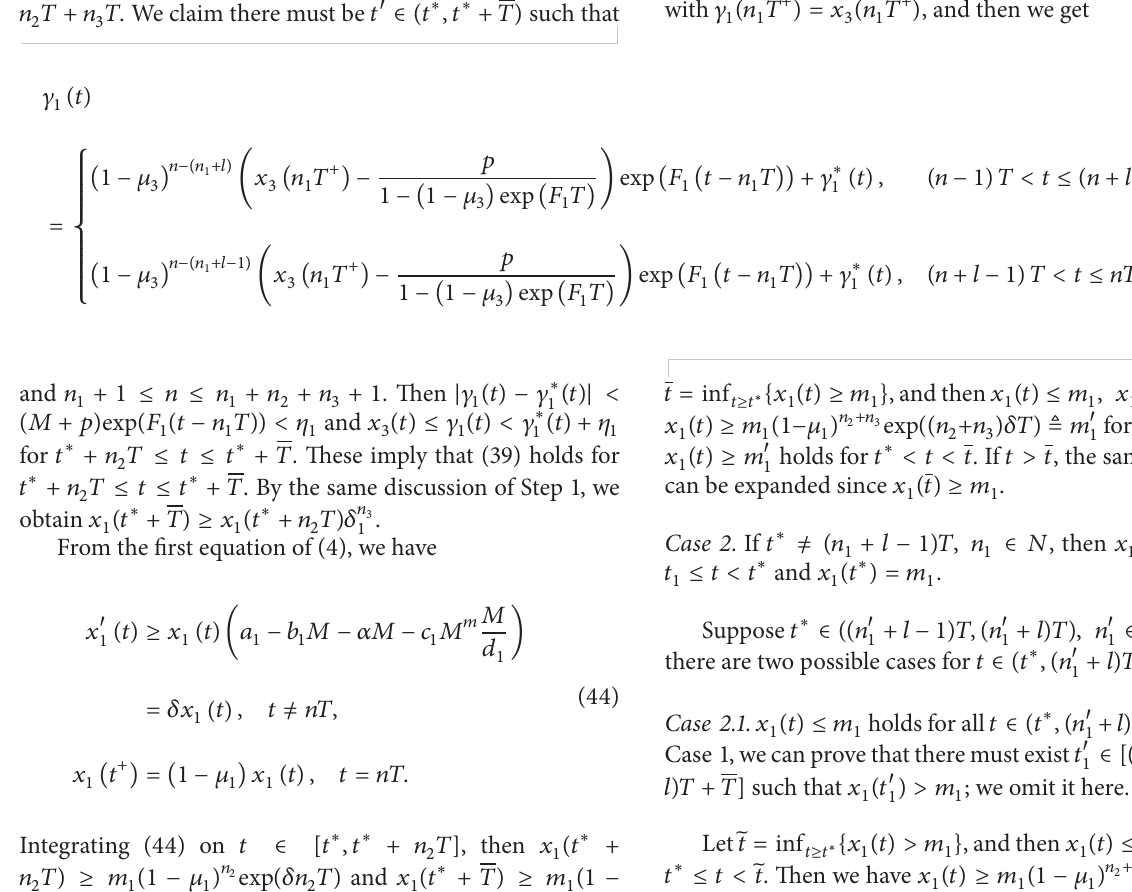
where 𝛿 = 𝑎 1 − 𝑏 1 𝑀 − 𝛼𝑀 − 𝑐 1 𝑀 𝑚 (𝑀/𝑑 1 ) < 0. Let 𝑇